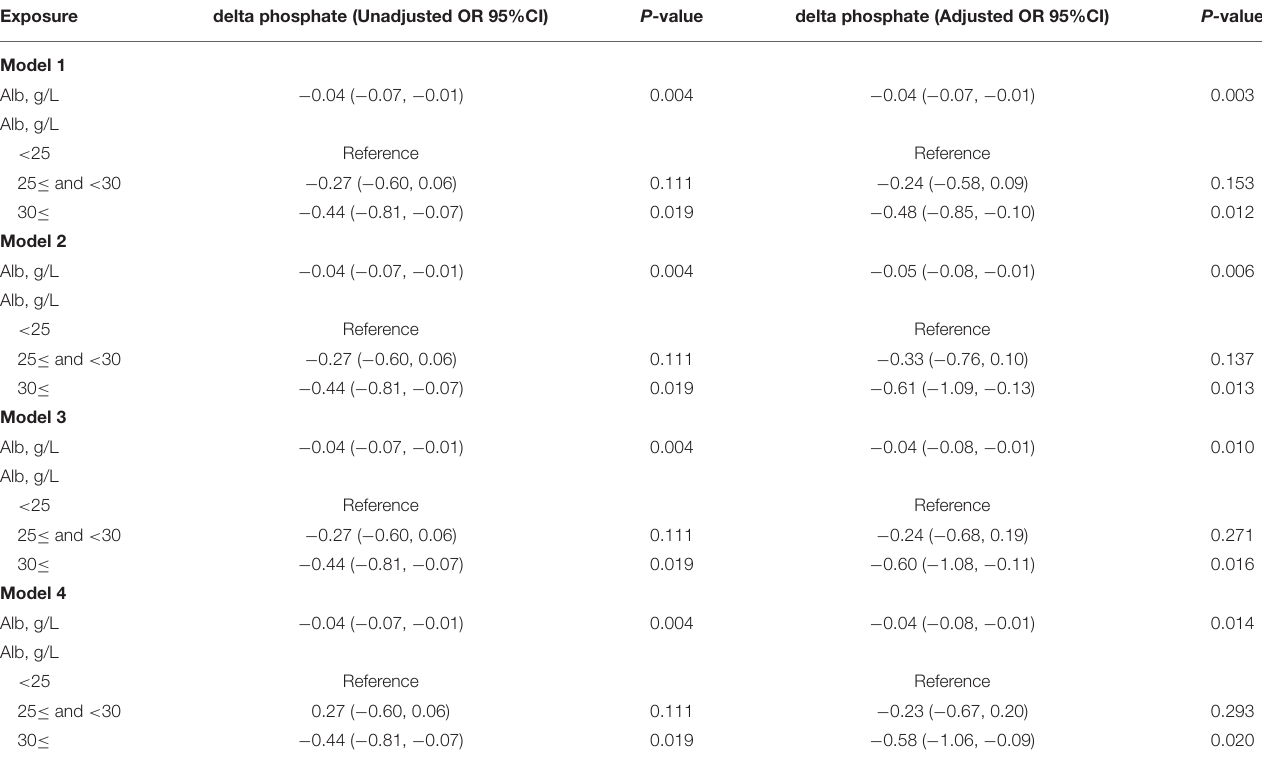
TABLE 4 | Multivariate logistic regression analysis for delta phosphate.